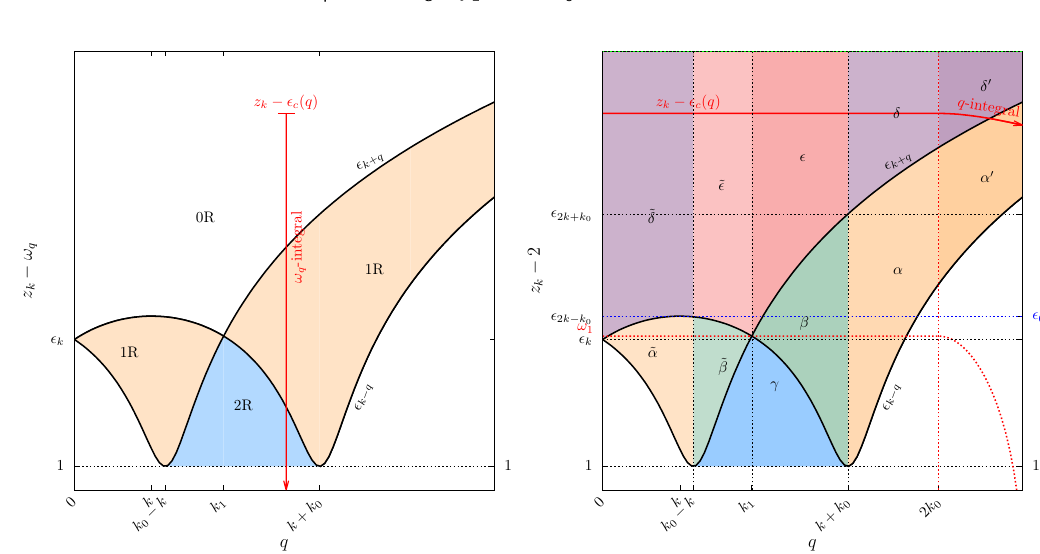
Figure 12: Resonance diagrams and integration over ω and q . The left panel shows q − ω the number of resonance angles in function of q and ω (the y -axis is z ): either q k q 0 (white region), 1 (yellow region) or 2 (blue region) resonance angles, depending on − ω whether the function u (cid:55)→ ε is monotonous or not, and whether z lies within k q k − q its energy-range or not (black solid line: value ε of the function in u = ± 1). As we k ∓ q − ω − ε ( q ) then integrate over ω in the pair-breaking continuum ( z varies from z q k q k c to −∞ , see the red vertical arrow on the left panel), the number of resonance angles changes according to a configuration α , β , γ , δ or ε (see Tab. 1) shown in color on the right panel. As we finally integrate over q (red solid curve on the right panel), the succession of greek-letter configurations gives rise to one of the superconfiguration of Tabs. 2 and 3. This superconfiguration itself changes when z passes one of the energy k < k < k lines shown as thin dashed horizontal curves. This figure is drawn for k 4 3 = (vertical sector number IV in Fig. 13) and k 0